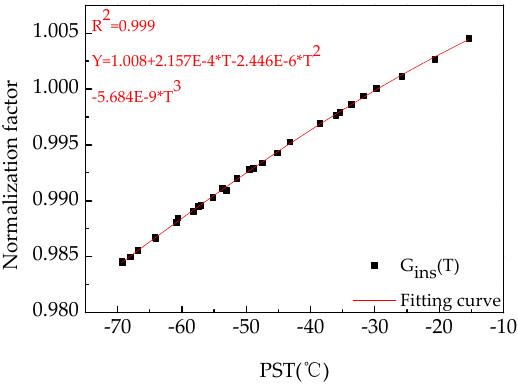
Figure 11. Results of G ins (T). This instrument ‐ level experiment determined that the responsivity was reduced by approximately 1.3% when the PSAC operated on orbit compared to the laboratory ‐ based radiometric test, with around 35 °C PST difference.